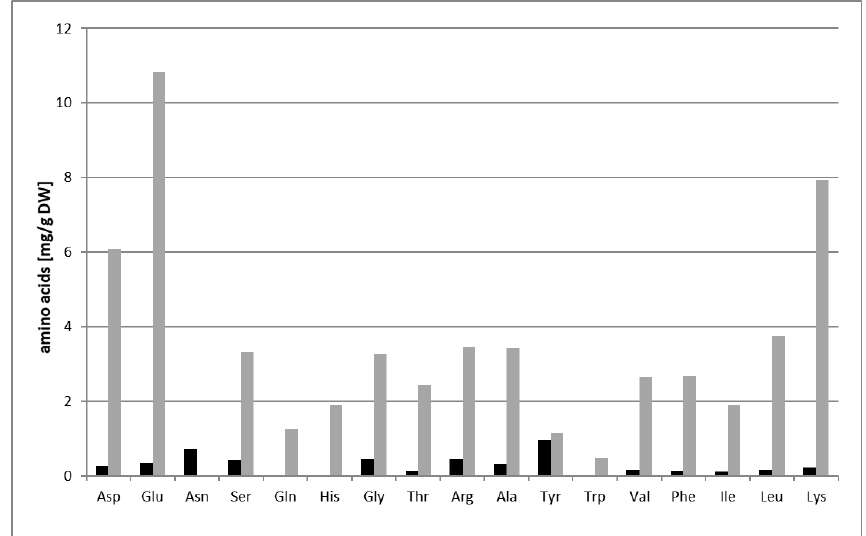
Fig. 9 : Content of the individual free amino acids before (dark symbols) and after (gray symbols) acid hydrolysis of the TA-mucilage. The average value of two measurements is given. n = 2.